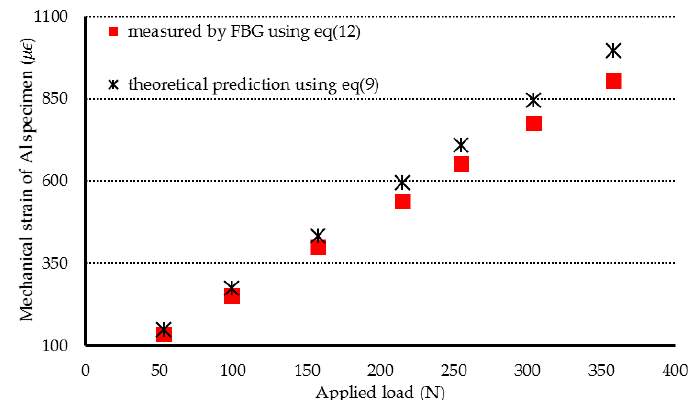
Figure 9. Mechanical strain of the Al specimen subjected to three-point bending with various loadings at the temperature of 78.1 °C.